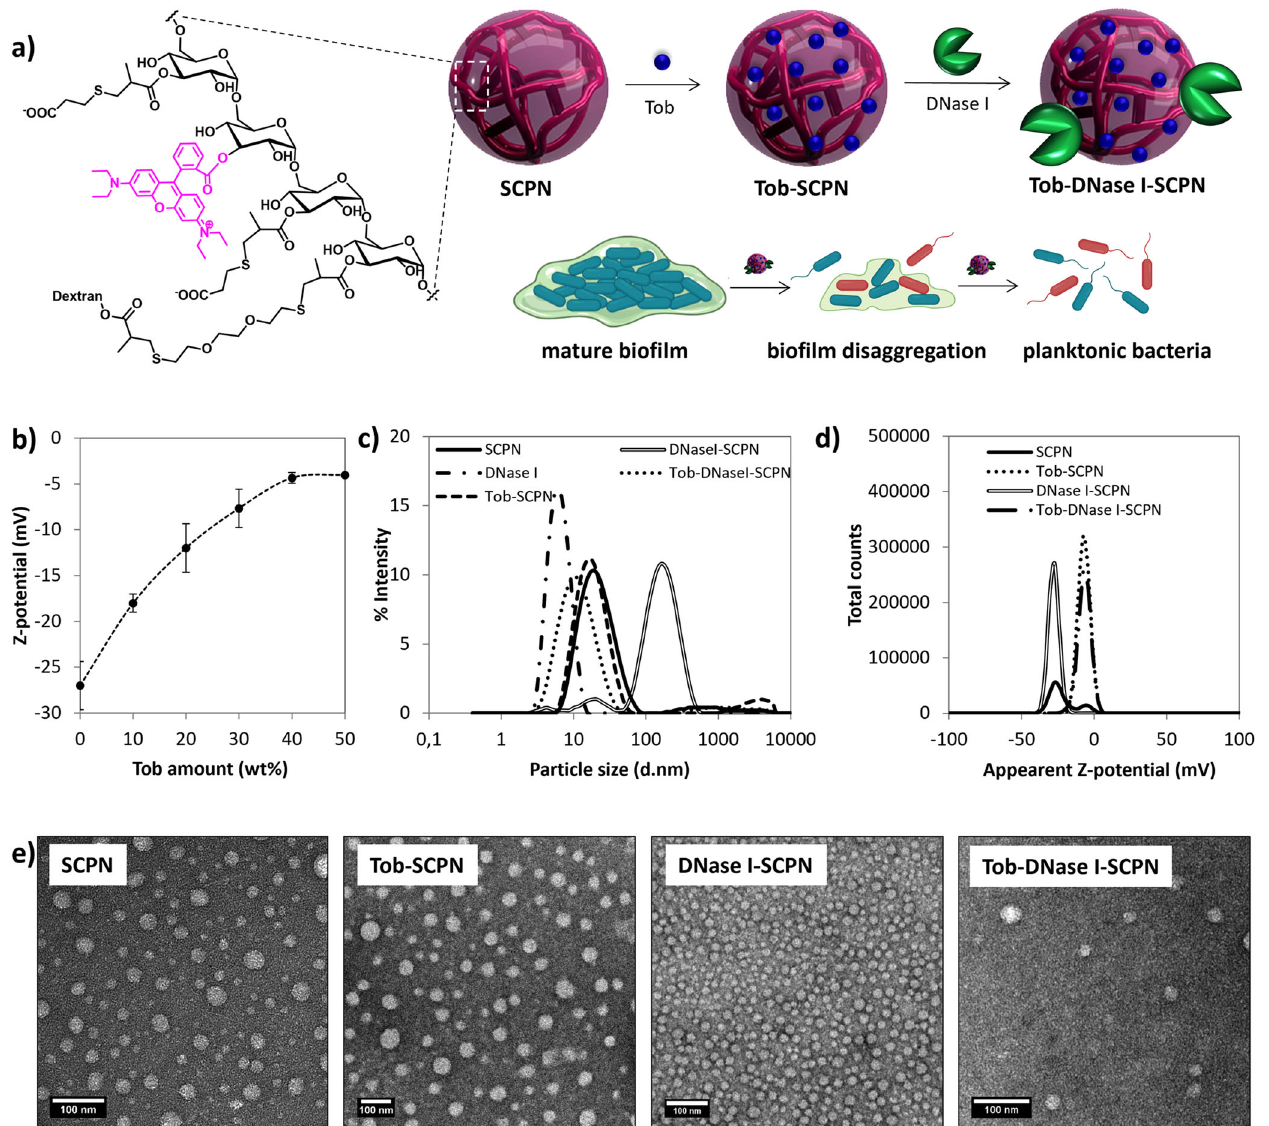
Fig. 1 SCPN synthesis and characterization. a Schematic representation for the synthesis of negatively charged SCPN labeled with rhodamine (SCPN), formulation with tobramycin (Tob) and DNase I, and expected action on mature bio fi lm; ( b ) variations in zeta potential for Tob-SCPN formulations as a function of the amount of tobramycin (wt%) added, as judged by aqueous electrophoresis at 25 °C in the presence of 1 mM of NaCl. Error bars indicate the standard deviation between two experiments with at least three replicates of each experiment; ( c ) size distributions obtained by DLS at 10 mg/ml in PBS; ( d ) surface charges at 10 mg/ml and 1 mM NaCl for SCPN, DNase I, Tob- SCPN, DNase I-SCPN, and Tob-DNase I-SCPN dispersions; and ( e ) transmission electron micrographs of the 4 formulations dried at room temperature (scale bar represents 100